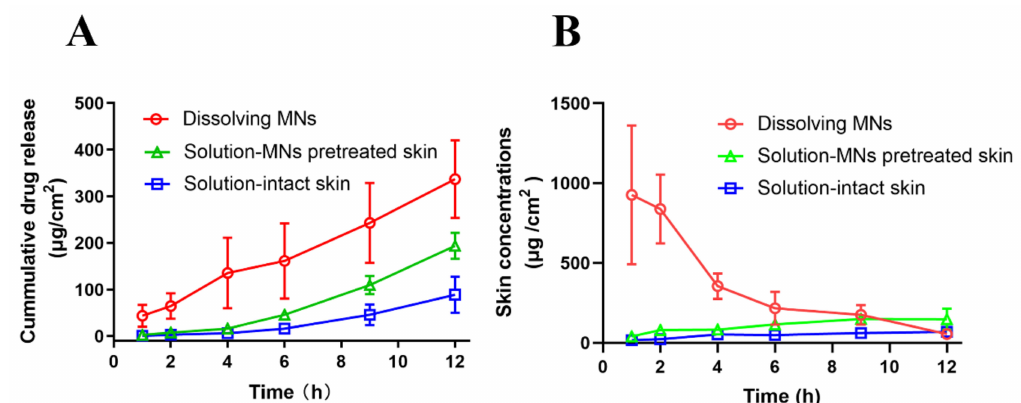
Figure 10. ( A ) Permeation profiles of propranolol hydrochloride into a receiver fluid after application of propranolol hydrochloride in different approaches to full thickness excised porcine skin ( n = 5). ( B ) Skin concentration of propranolol hydrochloride after application of propranolol hydrochloride in different approaches to full thick excised porcine skin ( n = 3). The amount of drug was 1.5